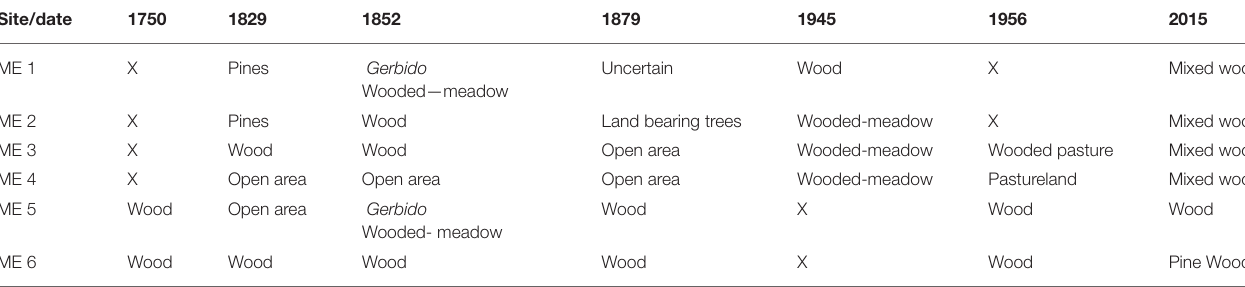
TABLE 4 | Merula Valley. Land use/cover history at the studied sites: results of map comparison (1750–2015A.D). Site/date